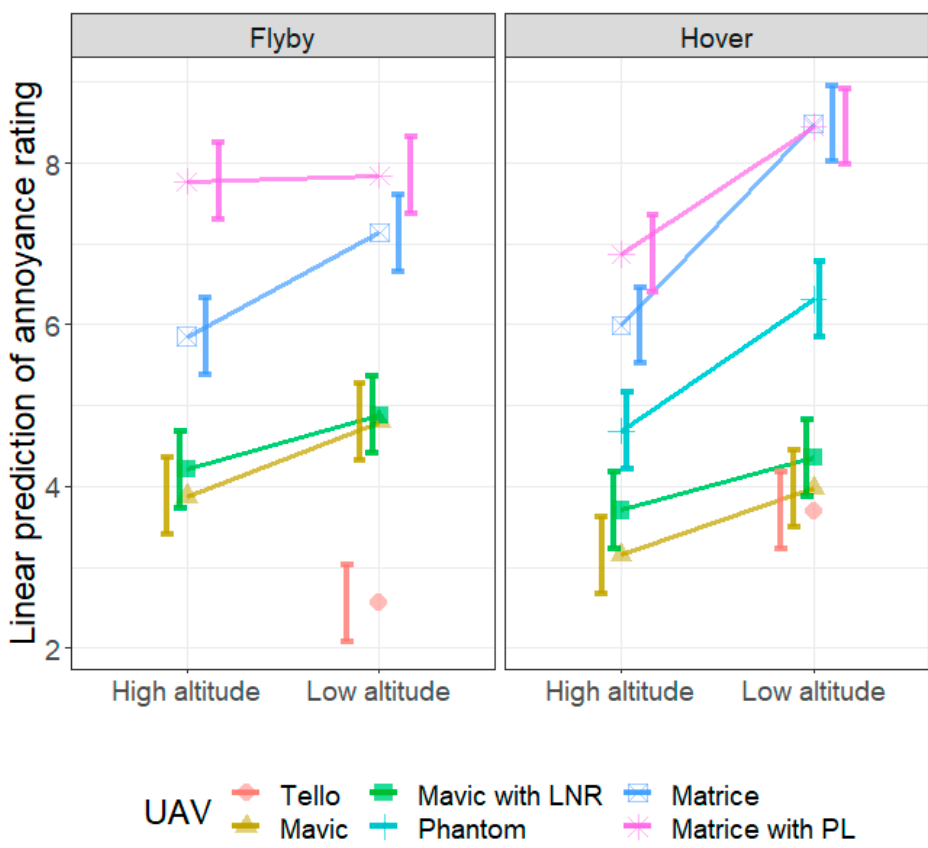
Figure 8. Linear prediction of the annoyance rating from the linear mixed model analysis. The effect of altitude for each UAV in flyby ( left ) and hover ( right ). The error bars represent the 95% confidence interval of the linear prediction.